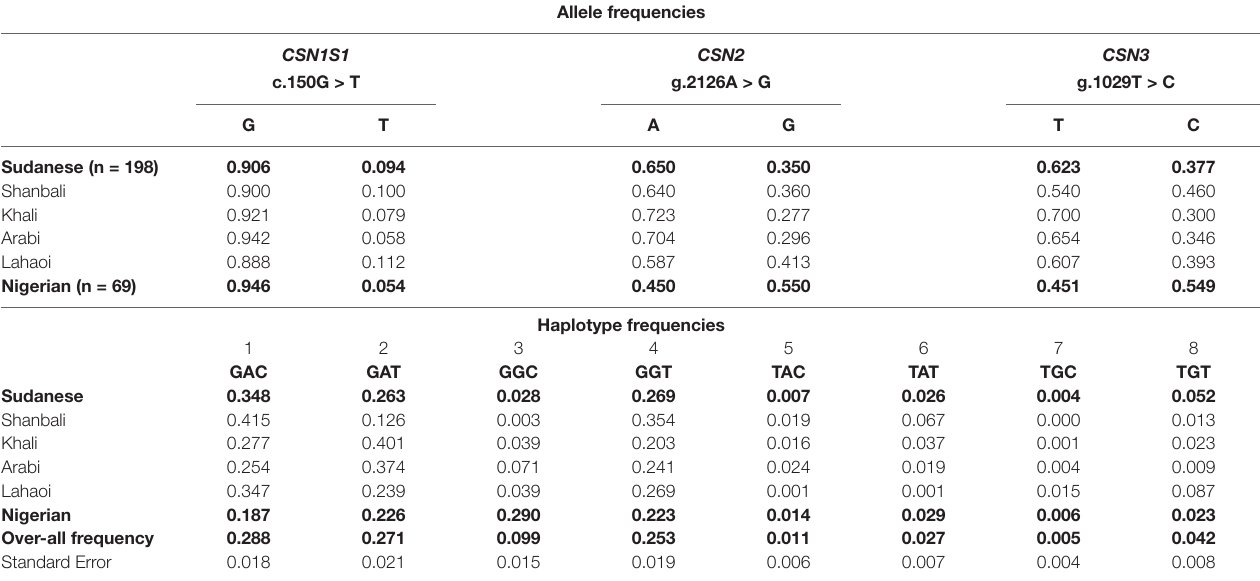
TABLE 7 | Allele and haplotype frequencies detected for the SNPs c.150G > T, g.2126A > G, and g.1029T > C at the casein loci in Sudanese and Nigerian dromedary populations.